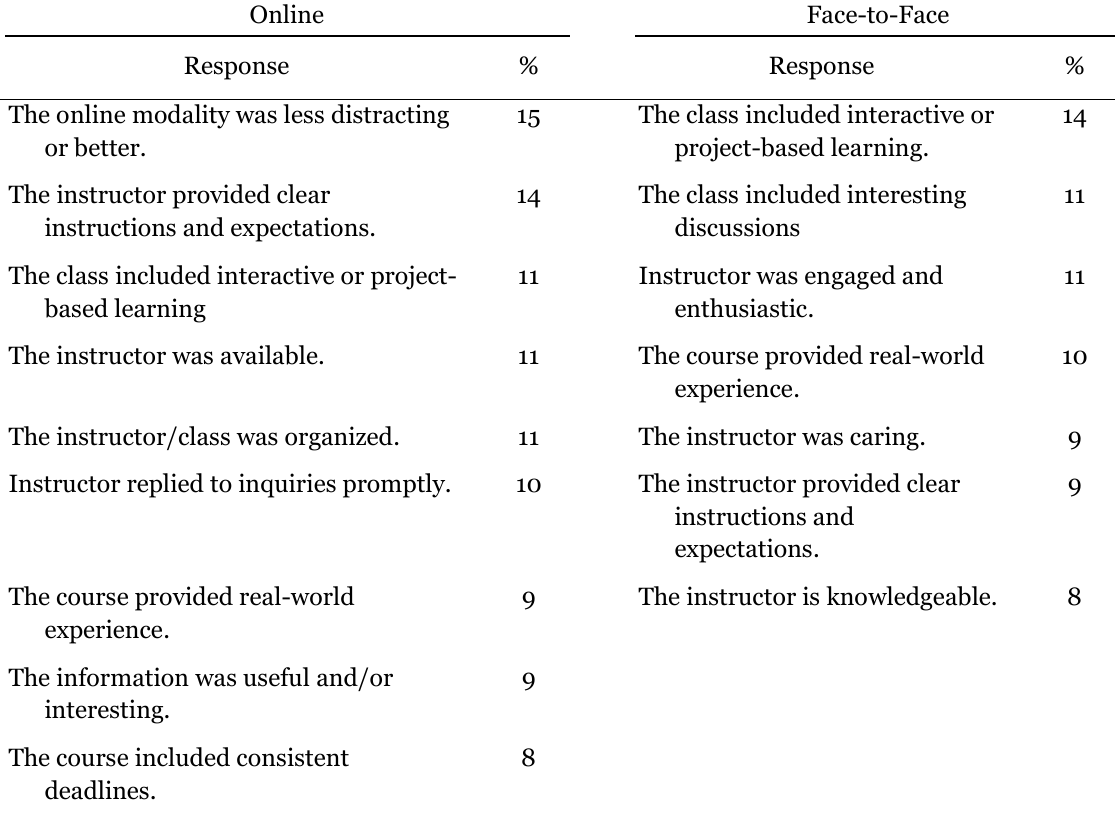
Prevalence of Open-Ended Comments Regarding What Makes a Class the Best, by